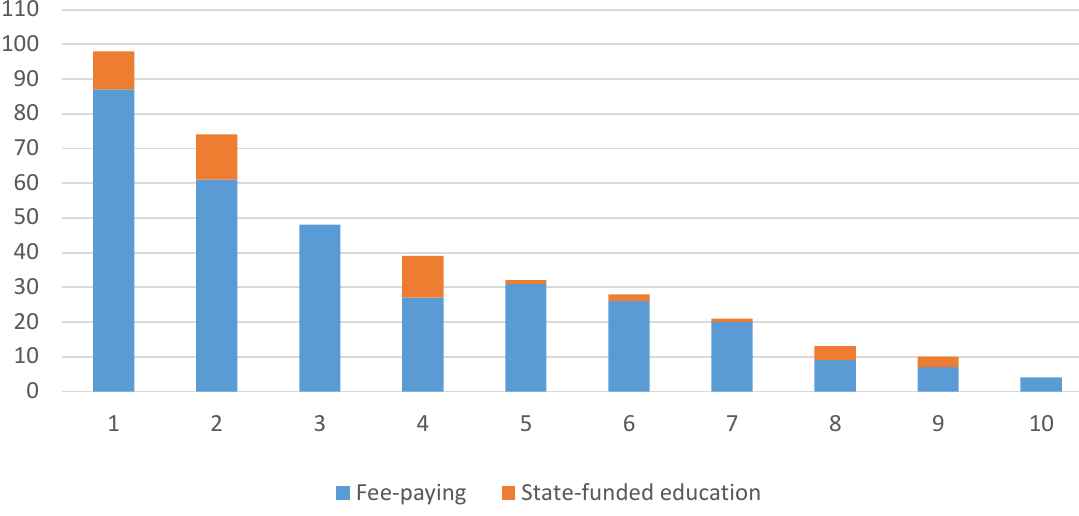
Figure 2. Number of enrolled in IHE of Dnipro in the specialty “Management” (undergraduate, full-time,